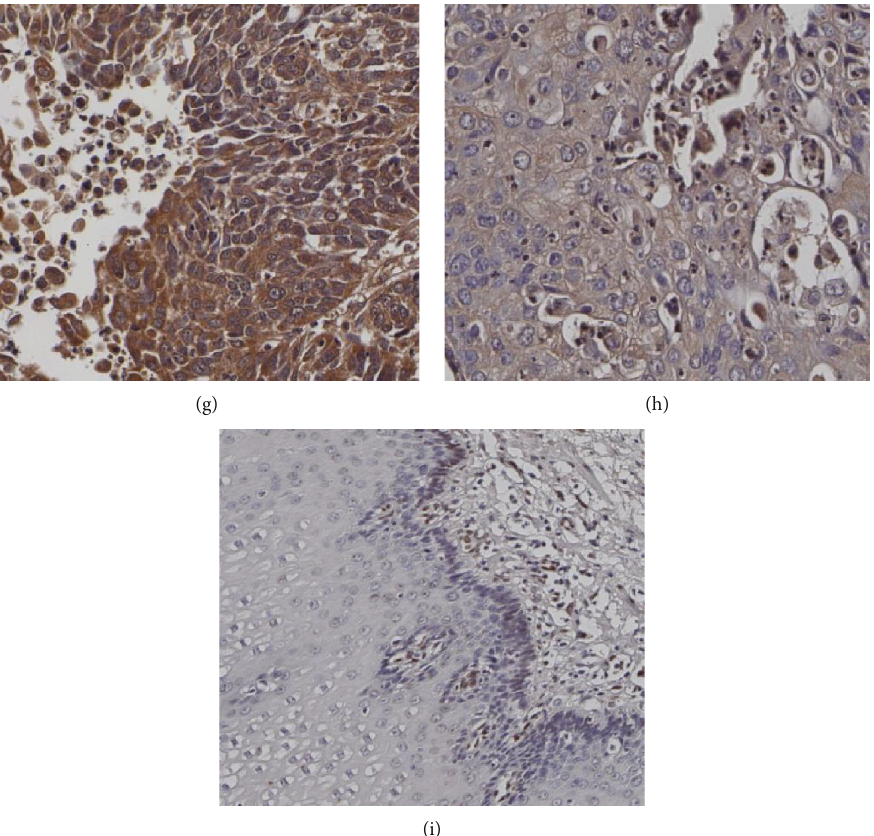
Figure 1: Immunohistochemical staining of FGF2, FGFR3, FGFBP1 expression in ESCC and normal esophagus mucosa. (a, b) Positive expression of FGF2 in ESCC tumor tissue; (c) positive expression of FGF2 in the basal layer of normal esophageal mucosa; (d, e) positive expression of FGFR3 in ESCC tumor tissue; (f) positive expression of FGFR3 in the basal layer of normal esophageal mucosa; (g, h) positive expression of FGFBP1 in ESCC tumor tissue; (i) negative expression of FGFBP1 in normal esophageal